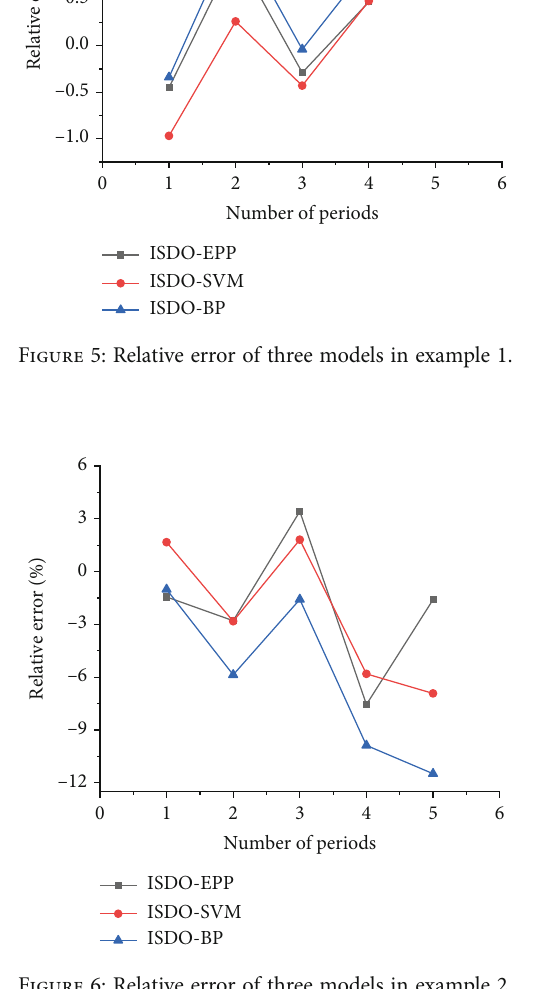
Figure 6: Relative error of three models in example 2.